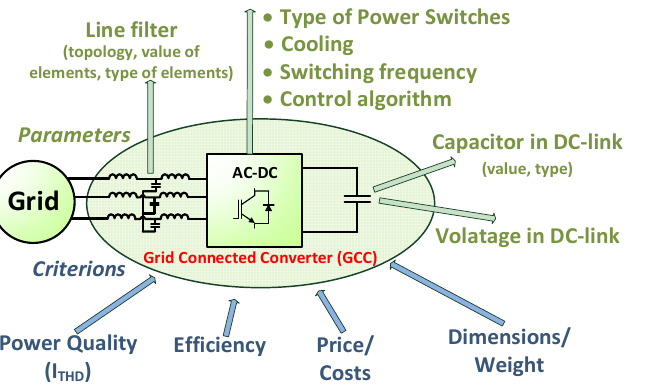
Fig. 1. Selected optimization parameters (variables) and objectives (criterions) for grid connected AC-DC converter